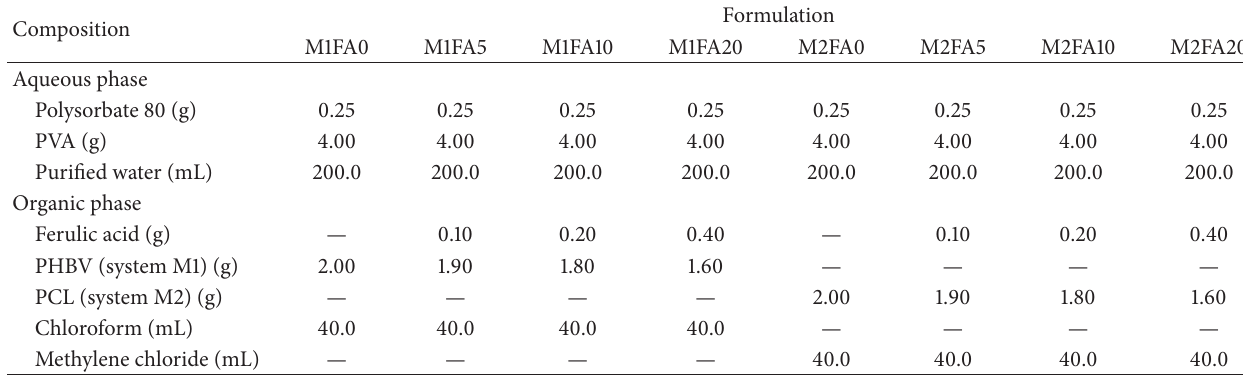
Table 2: Composition of ferulic acid-loaded and unloaded PHBV/PCL